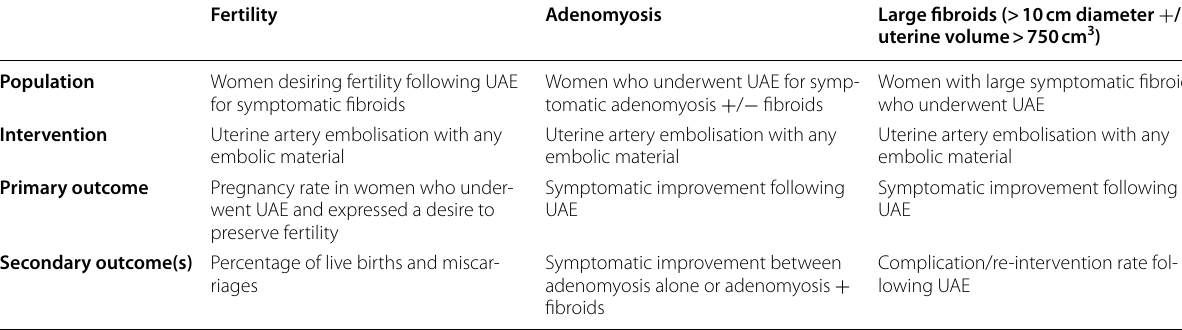
Table 1 Population, interventions, outcomes assessed for each topic Fertility